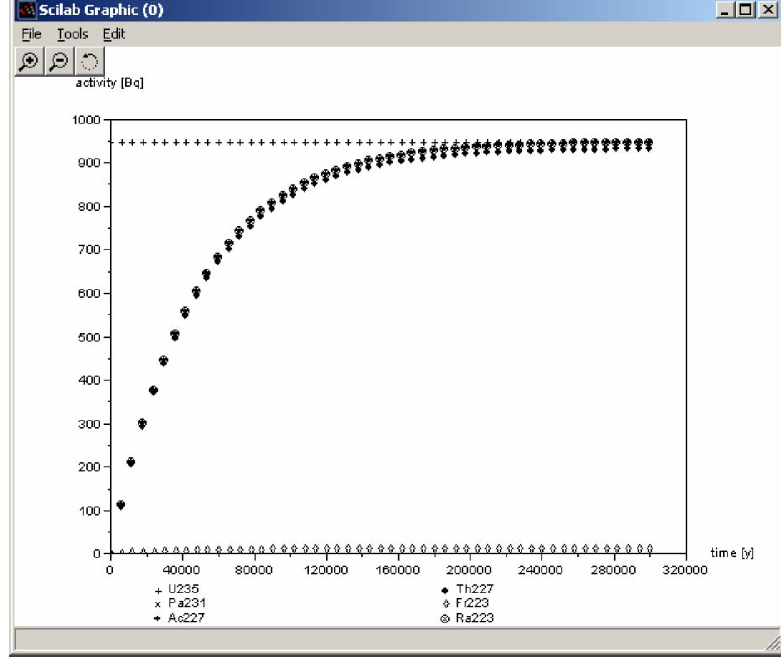
Fig. 3 Time dependence of the activity of six genetically coupled radionuclides from uranium decay series 4n+3 calculated by the elaborated